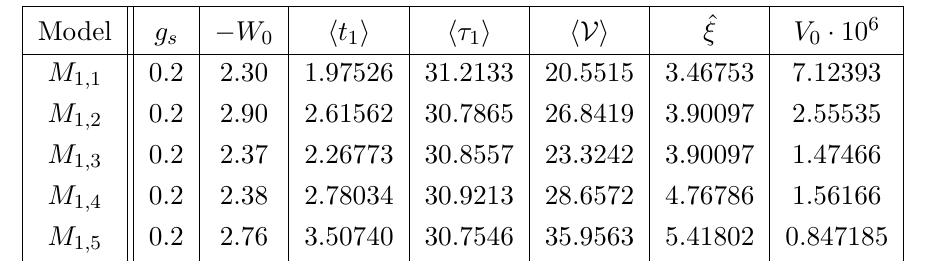
, K = 1 , A = 1 and the axion ρ cs 1 16